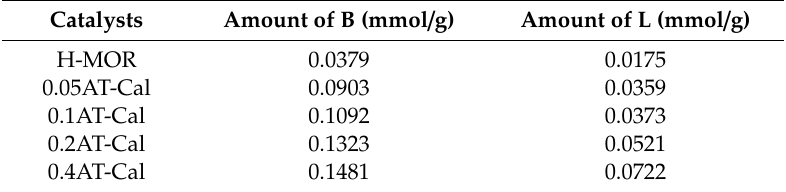
Figure 5. Py-IR spectra of the samples before and after alkali treatment. Table 2. Acid properties of the samples before and after alkali treatment